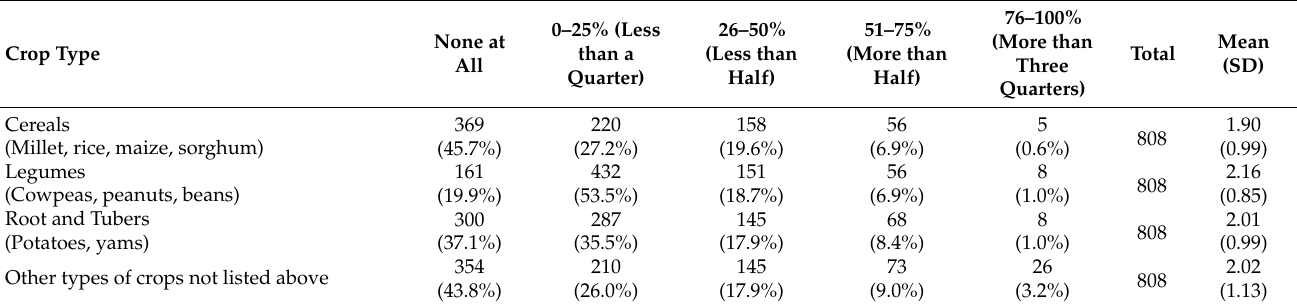
Table 4. How much of a reduction in crop yields per crop type (e.g., cereals, legumes, tubers) did you experience due to the impact of COVID-19 during this harvest